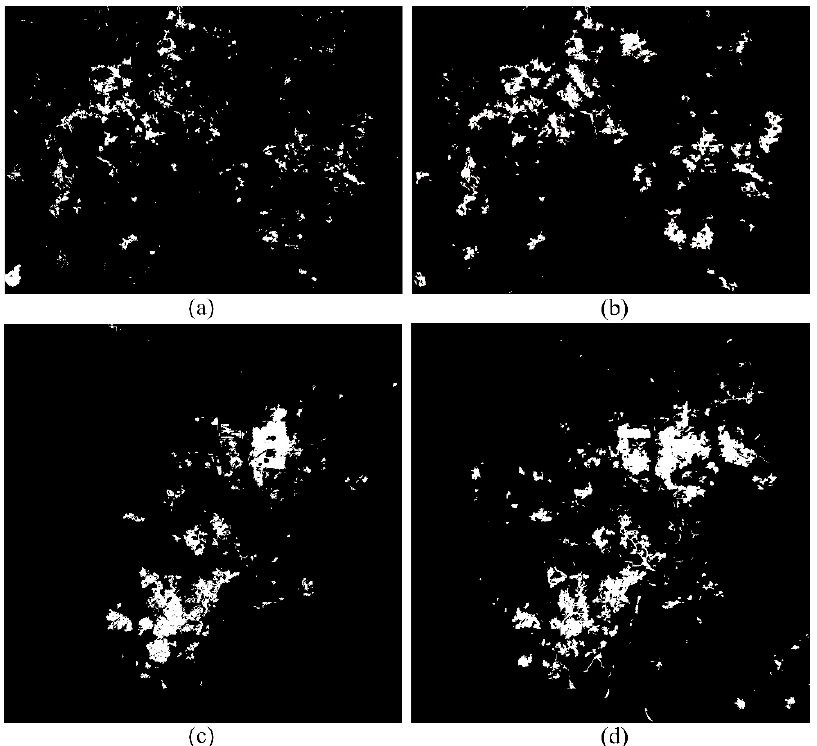
Figure 5. REO (Rare-earth ore) mining area extraction results. ( a ) REO mining area extraction result of the GF-1 image in Lingbei; ( b ) result of ALOS image in Lingbei; ( c ) result of the GF-1 image in Shipai; ( d ) result of the ALOS image in Shipai.